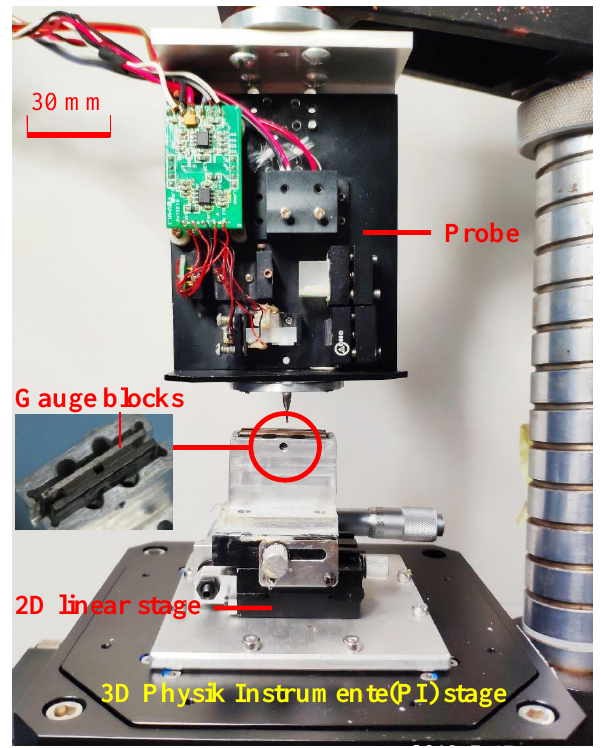
Figure 10. Photograph of the experimental setup.